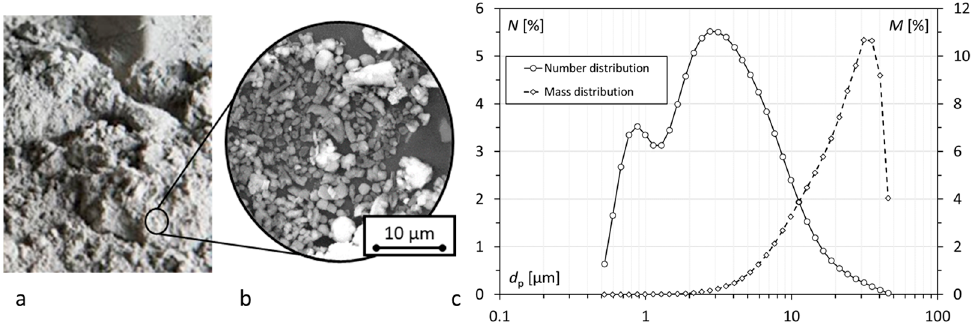
Figure 1. ( a ) Digital and ( b ) SEI-SEM images of the powder in the as-received condition, ( c ) num- ber, N, and mass distributions, M, of the raw meal powder. distributions, M, of the raw meal